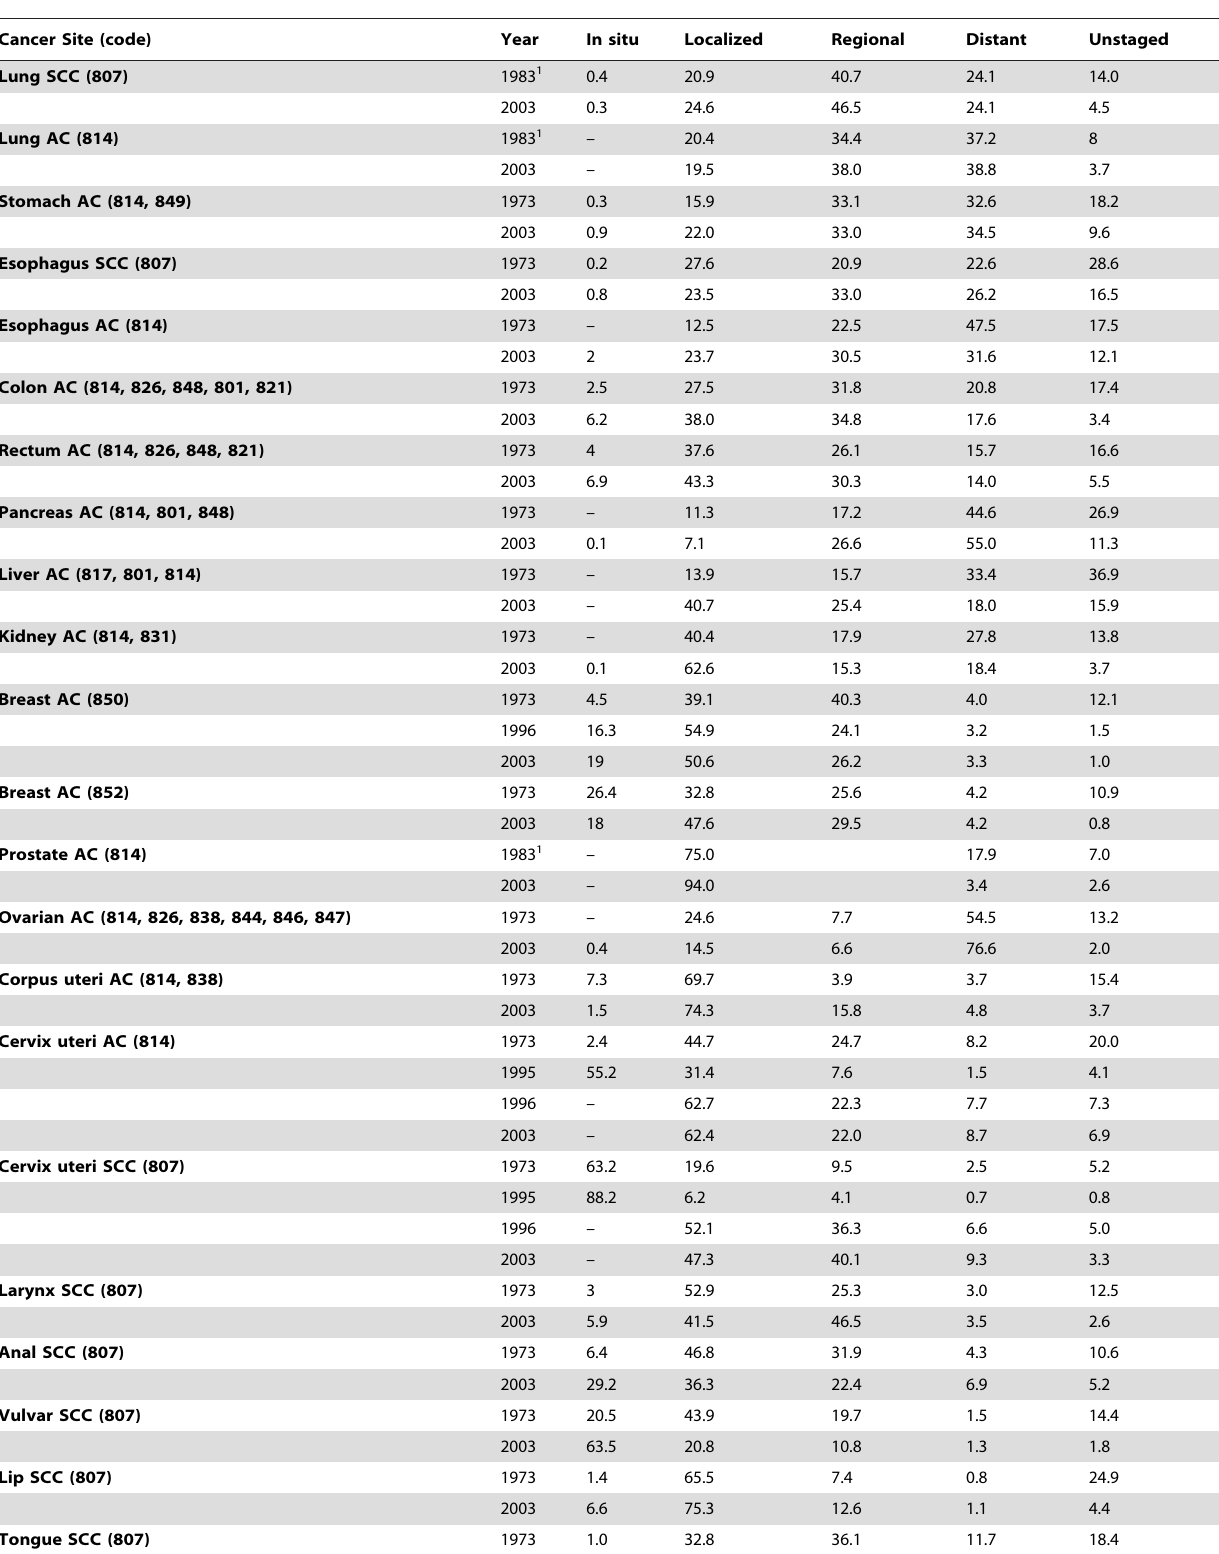
Table 1. The frequencies of stages at cancer diagnosis in the SEER Registry, 1973–2003, in percent. (Initial, final, and years of significant changes – if needed - in stages distribution are